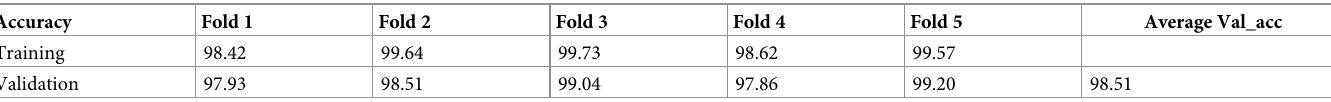
Table 17. Result of 5-Fold cross-validation on augmented